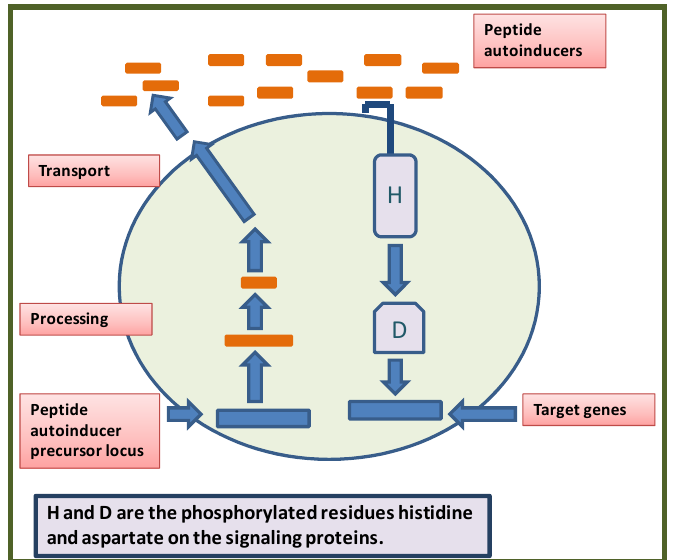
Figure 2. A typical quorum-sensing system in Gram-positive